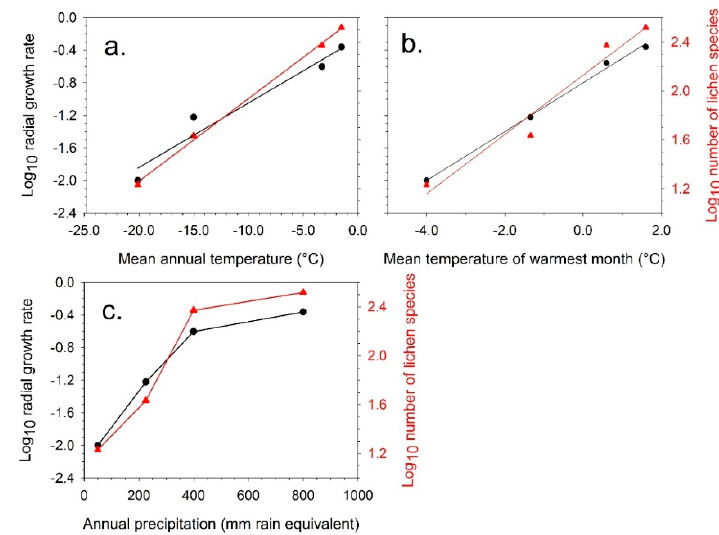
Figure 4. Relationship of log 10 lichen radial growth rate ( • ) and log 10 number of lichen species ( (cid:78) ) with ( a ) mean annual temperature ( ◦ C), ( b ) mean temperature of warmest month, and ( c ) annual rainfall (mm rain equivalent). Significance of regressions in ( a ) are P = 0.0252, r 2 = 0.925 and P = 0.0009 and r 2 = 0.997, and in ( b ) P = 0.0019, r 2 = 0.994 and P = 0.0198 and r 2 = 0.941, for lichen radial growth rates and number of lichen species, respectively. Table 1. Radial growth rate of Buellia (* Buellia frigida ; ** Buellia latemarginata ) species and main climatic parameters from Antarctic localities (Sancho et al. 2007, modified).